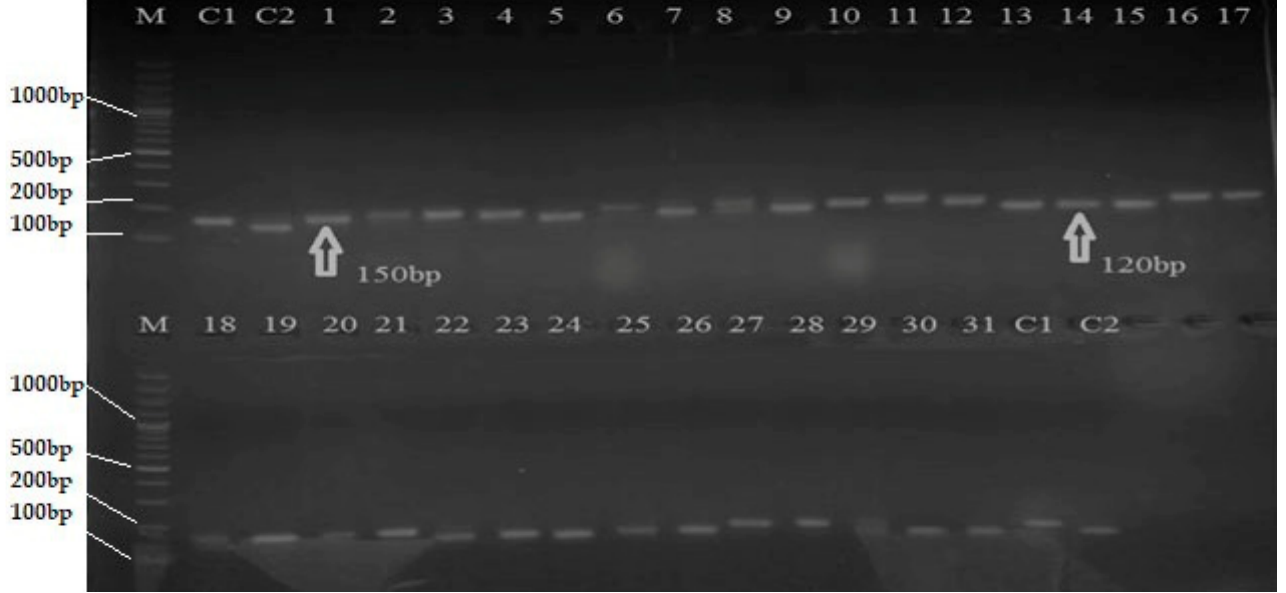
Figure 4. PCR analysis of RILs of rice for the presence of Xa 4 gene (Arrow showing 150 bp bands linked to Xa 4 gene). M = 100 bp DNA ladder, C1 = Basmati-385, C2 = IRBB59, line 1–31 = Selected genotypes.